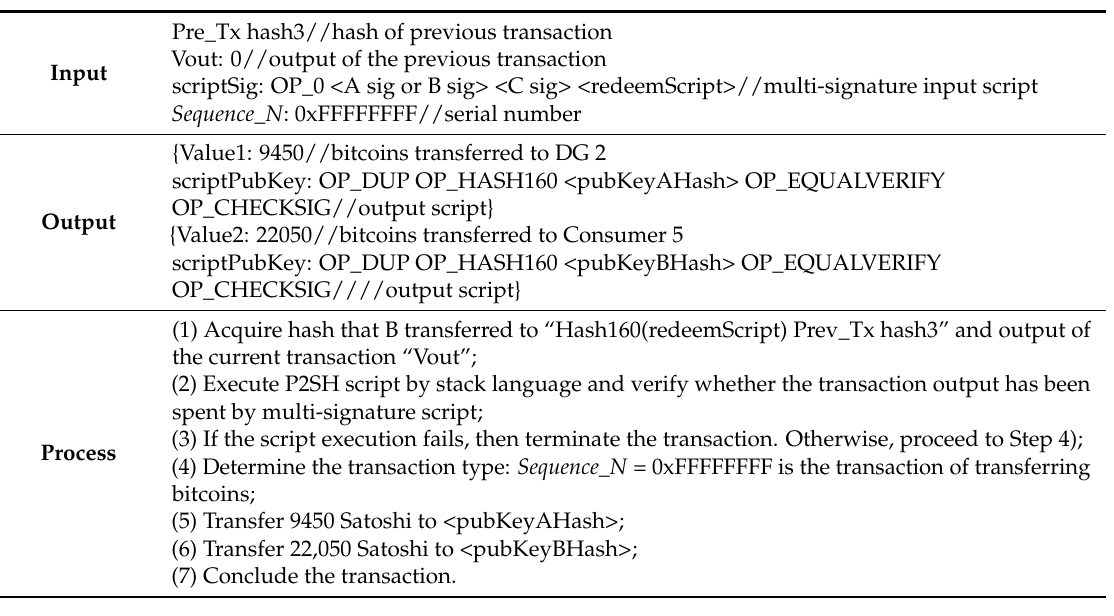
Table 5. Transaction of arbitration